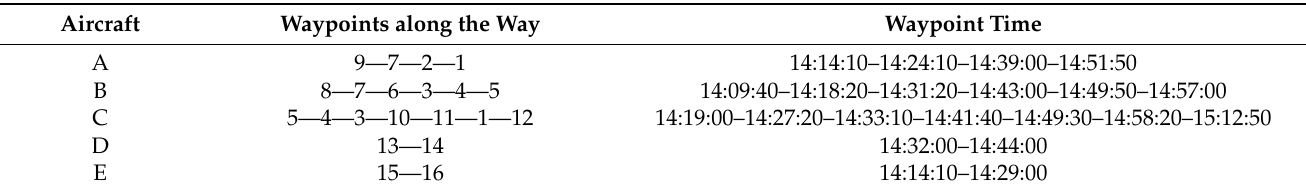
Table 2. The flight plans of each of the five